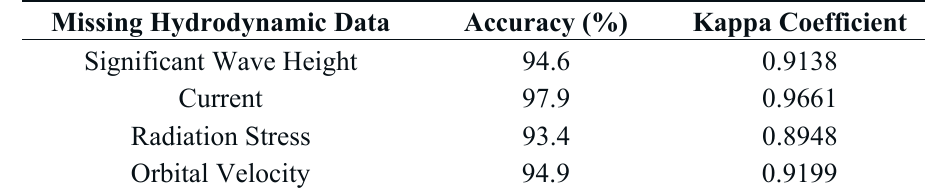
Table 6. Test results to determine importance of hydrodynamic parameters to the habitat mapping